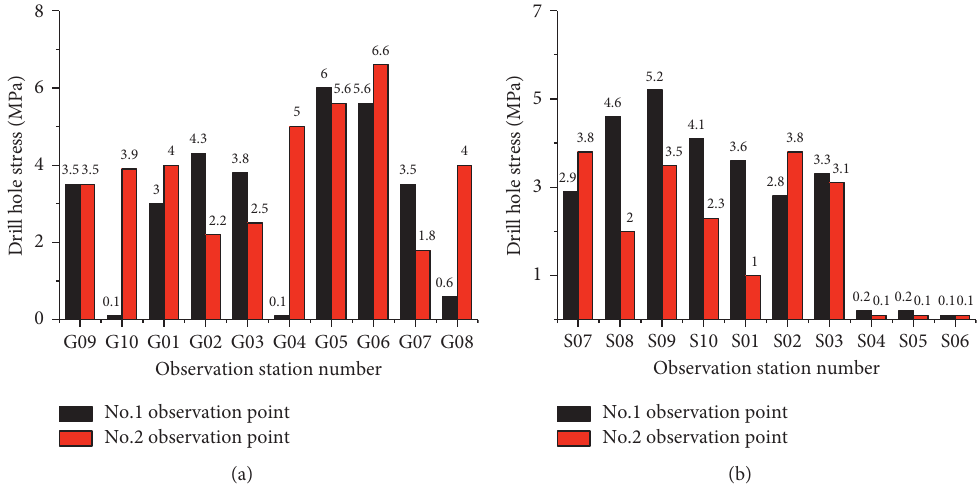
Figure 15: Stress monitoring results of No. 1412 working face on March 2. (a) No. 1412 upper roadway. (b) No. 1412 lower